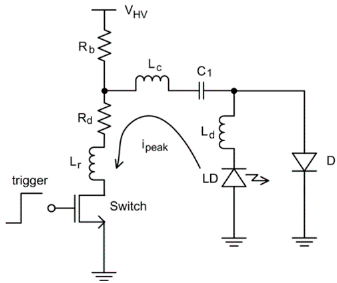
Figure 1. Structure of the typical laser diode driver . Reproduced with permission from Ref. [29].